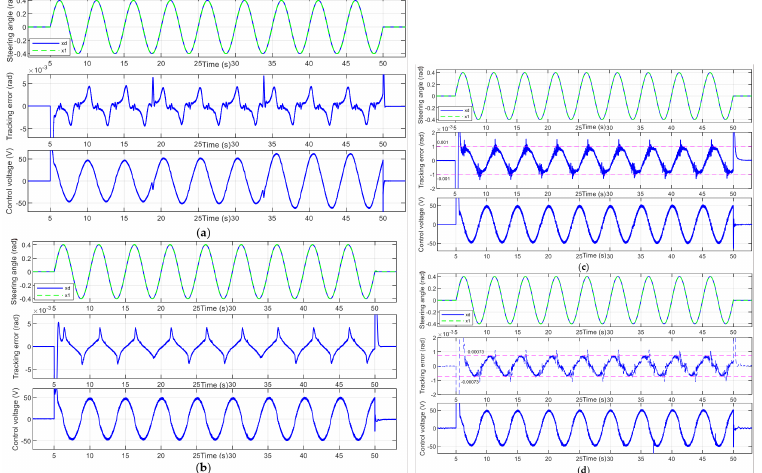
Figure 4. Tracking performance and the control voltage: ( a ) ASMC algorithm; ( b ) TDE-STSMC